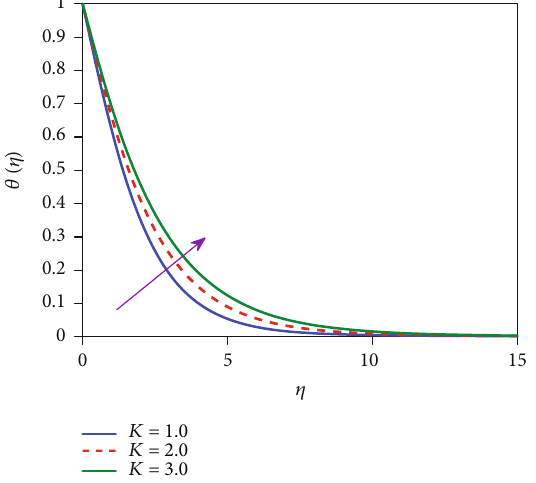
Figure 26: E ff ect of γ on the temperature θ ð η Þ 1